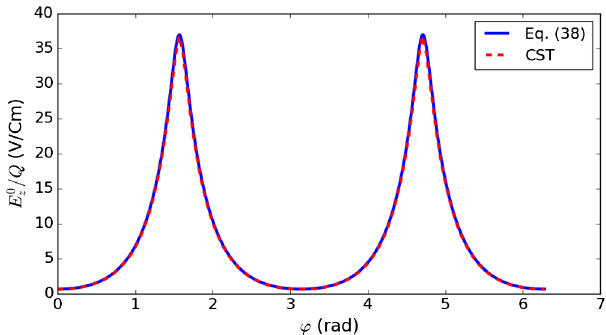
FIG. 4. Comparison between the longitudinal electric field per unit of charge computed with Eq. (38) (blue line) and by CST (red dashed line) with 40 summation terms, calculated in μ ¼ 0 . 1 at 100 MHz as a function of φ